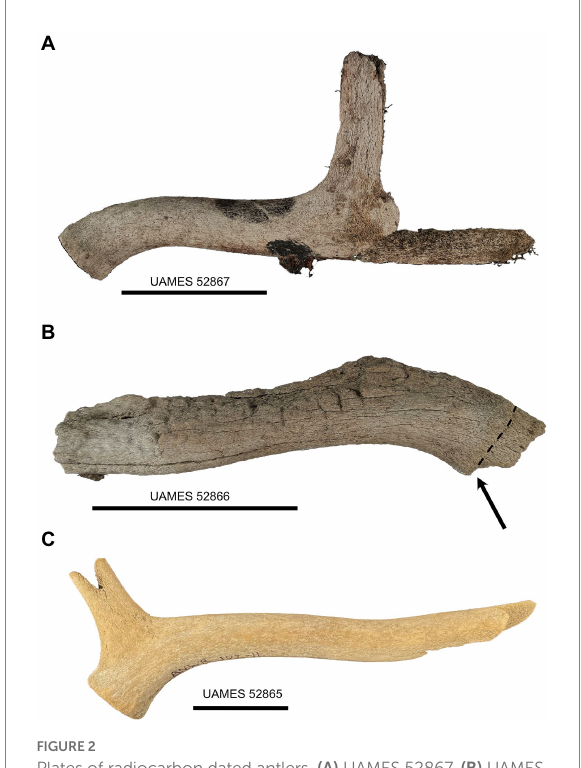
FIGURE 2 Plates of radiocarbon dated antlers. (A) UAMES 52867. (B) UAMES 52866; dashed line identifies well-delimited pedicle attachment surface; arrow identifies exposed attachment surface. (C) UAMES 52865. Scale bars are 5 cm.